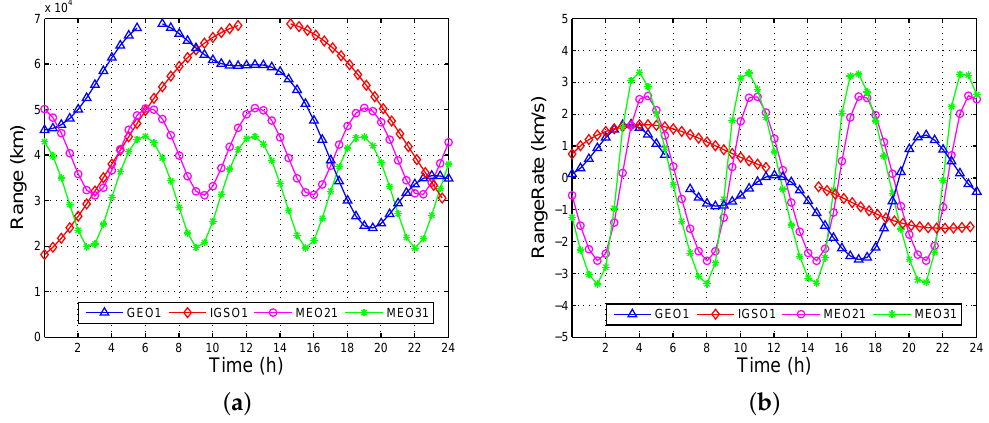
Figure 1. Characteristics of the ISL signal: ( a ) range to MEO11; and ( b ) rangerate to MEO11.